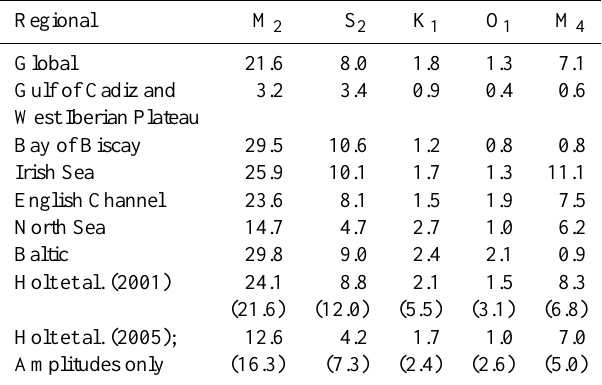
Table 2. RMS between observed and modelled (runbt) tidal ellipse parameters. Units are in cms − 1 for the semi-major axis (SEMA) and the semi-minor axis (SEMI) and in ◦ for the inclination (Inc) and the phase (Pha). Statistics are also performed over the area cov- ered by the studies of Holt et al. (2001, 2005) (48 ◦ N–62 ◦ N, 12 ◦ W– 13 ◦ E), and results obtained in the studies of Holt et al. (2001, 2005) are presented for comparisons (values in brackets). The